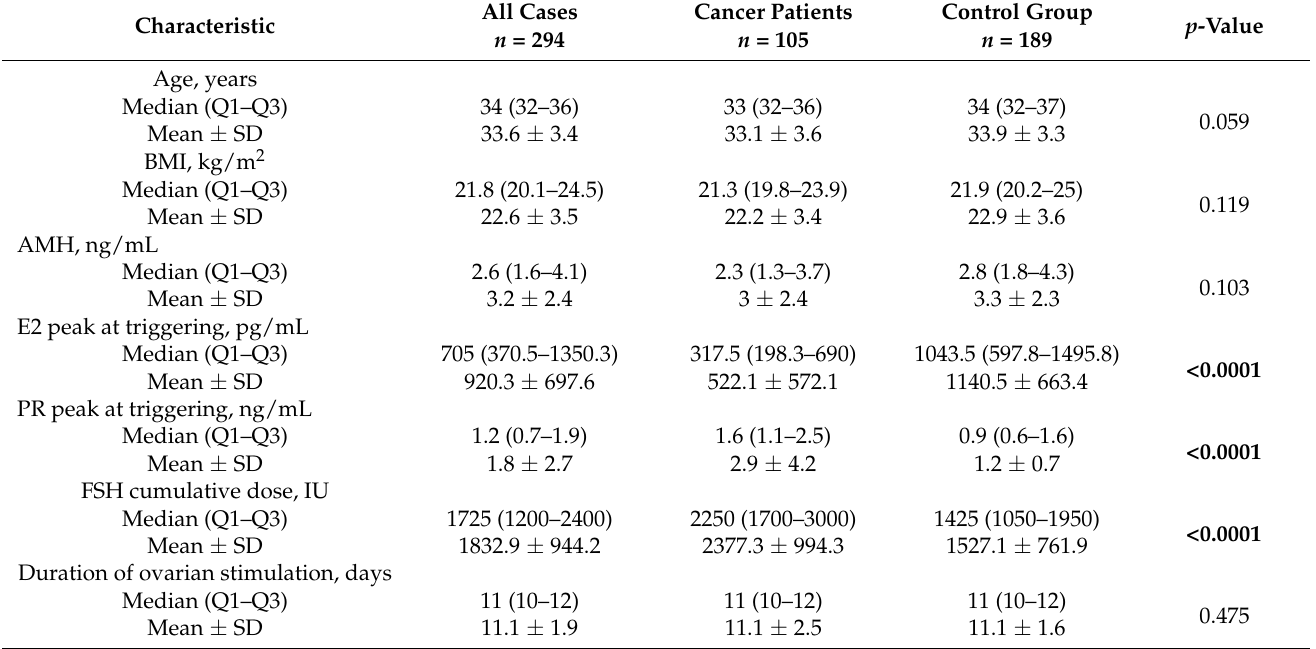
Table 1. Demographic and clinical characteristics of the study population according to the type of patient (cancer versus